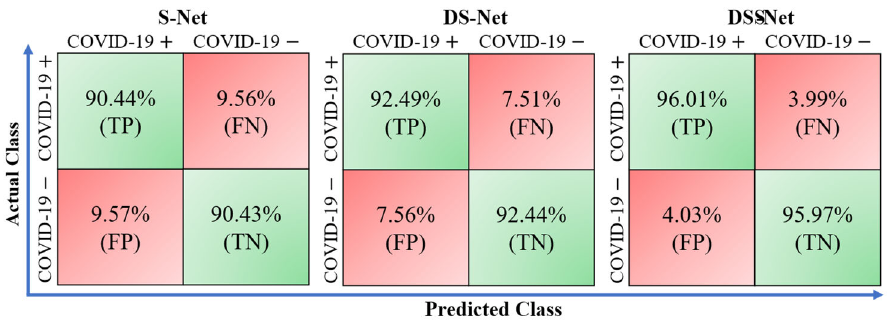
Figure 5. Comparative ROC plots of DSS ‐ Net (best model), DS ‐ Net (second ‐ best model), and S ‐ Net (baseline model). These plots show the trade ‐ off between the average false ‐ positive rate (FPR) and true ‐ positive rate (TPR) of each model according to different thresholds.